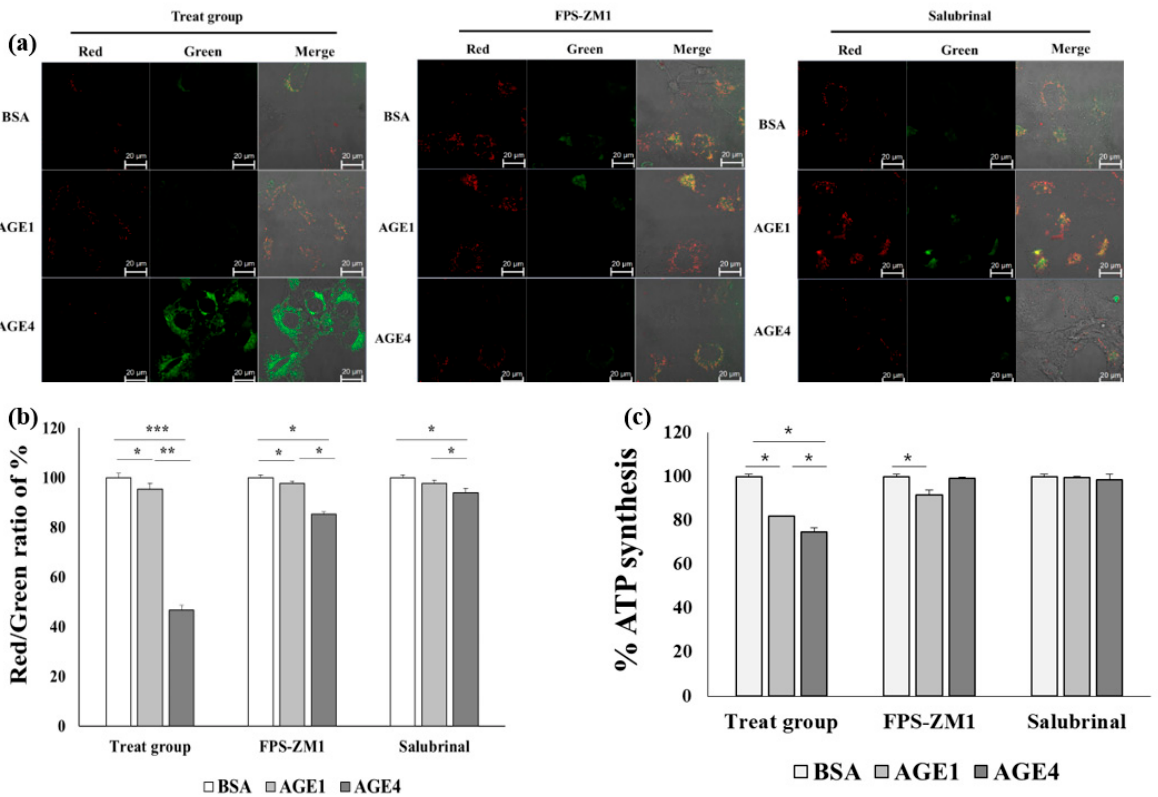
Figure 6. Effects of AGE4–RAGE axis on the mitochondrial dysfunction in HK-2 cells. ( a ) The mitochondrial membrane potential (MMP) was measured by confocal microscope. A microscope was used to amplify each image to magnification of 100. ( b ) MMP was determined using a fluorometric assay on a multi-microplate reader. ( c ) The extent of ATP synthesis was determined using an ATP detection assay. The experiments were conducted independently more than three times. * p < 0.05, ** p < 0.01, and *** p < 0.001; groups were compared by t